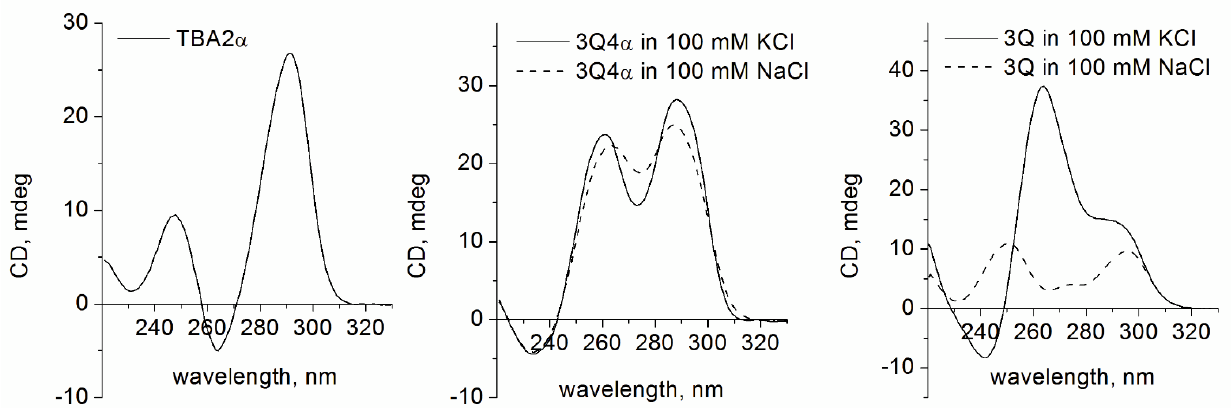
Figure 4. CD spectra of the modified variants TBA2 α , 3Q4 α , and 3Q at 20 ◦ C in 10 mM sodium cacodylate (pH 7.2) and 100 mM KCl or 100 mM NaCl (3Q4 α and 3Q).